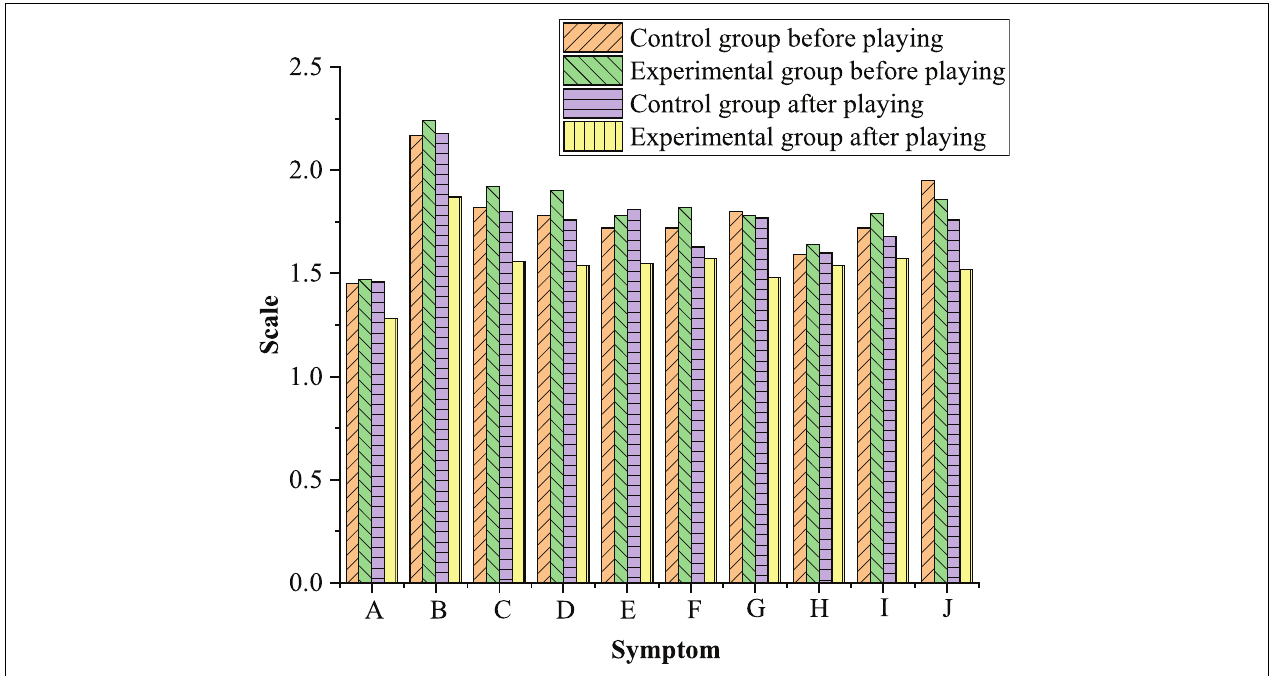
FIGURE 11 | Comparison of bad emotions of students before and after the Sand Table game intervention. (A), somatization; (B), compulsion; (C), interpersonal sensitivity; (D), depression; (E), anxiety; (F), hostility; (G), fear; (H), paranoia; (I), psychosis; (J), other bad emotions or manifestations.